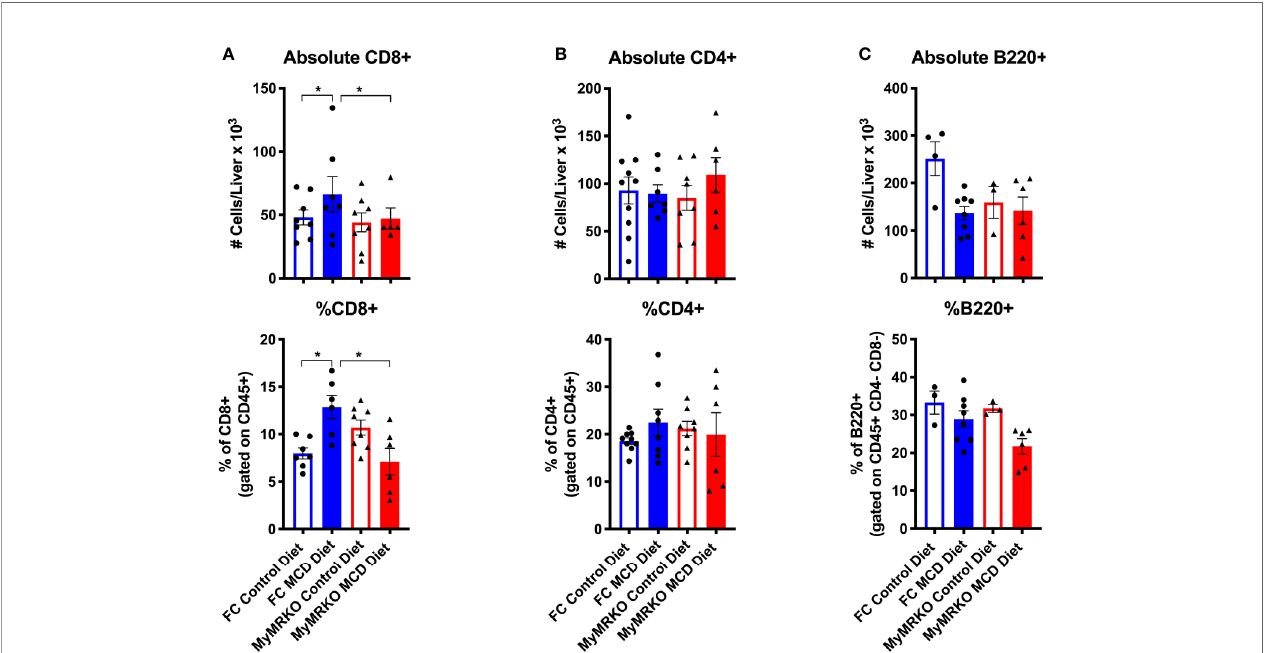
FIGURE 4 | Changes in lymphoid cell in fi ltration in fl oxed control (FC) mice is mainly due to CD8 + T cells. To measure what type of lymphocytic response is involved in NASH, we evaluated the absolute number and percentage of CD8 + T cells (A) , CD4 + T cells (B) , and B220 + B cells (C) at the endpoint. Flow cytometry characterization was performed individually for each animal per group, achieving n= 7 – 8, and following the gating strategy described in Supplementary Figure 1 . Absolute counting was performed with Count Bright ™ absolute counting Beads (described in materials and methods). Statistical analysis was performed with one-way ANOVA comparing all treatments, with Tukey post-test. All fi gures display mean ± SEM. Statistical differences were considered signi fi cant according to *p <0